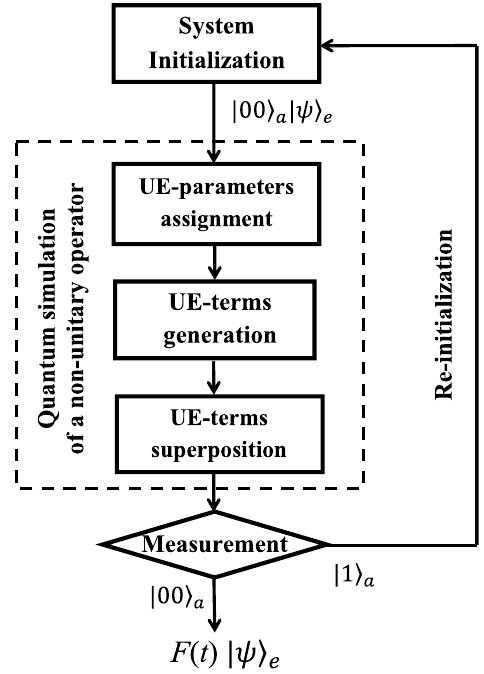
Figure 2. Flowchart to simulate F ( t ) in a quantum computer. The system is initialized in the first block. The second block includes UE-parameters assignment, UE-terms generation and superposition. Finally, measurements are performed on the ancillary subsystem to achieve the simulation of F ( t ) in an indeterministic